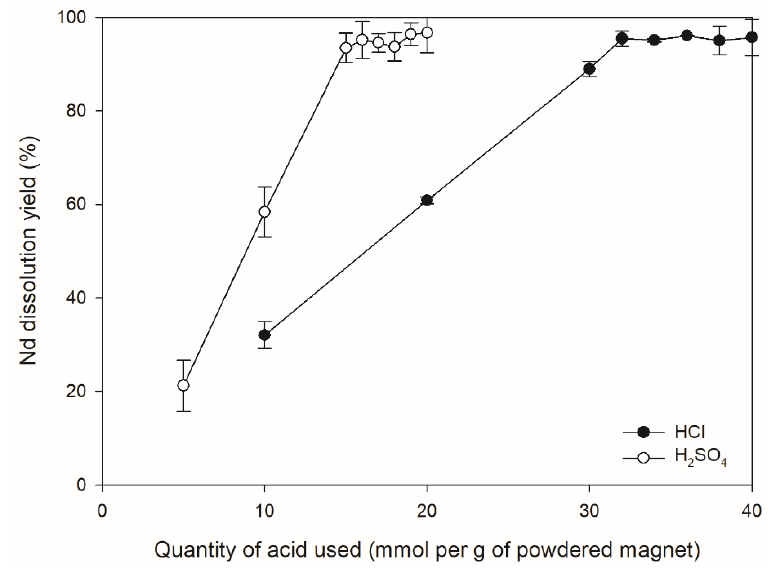
Figure 2. Nd dissolution yield (%) as a function of the amount of acid (HCl or H 2 SO 4 , in mmol) for 1 g of powdered magnet after a digestion by FID (300 s).